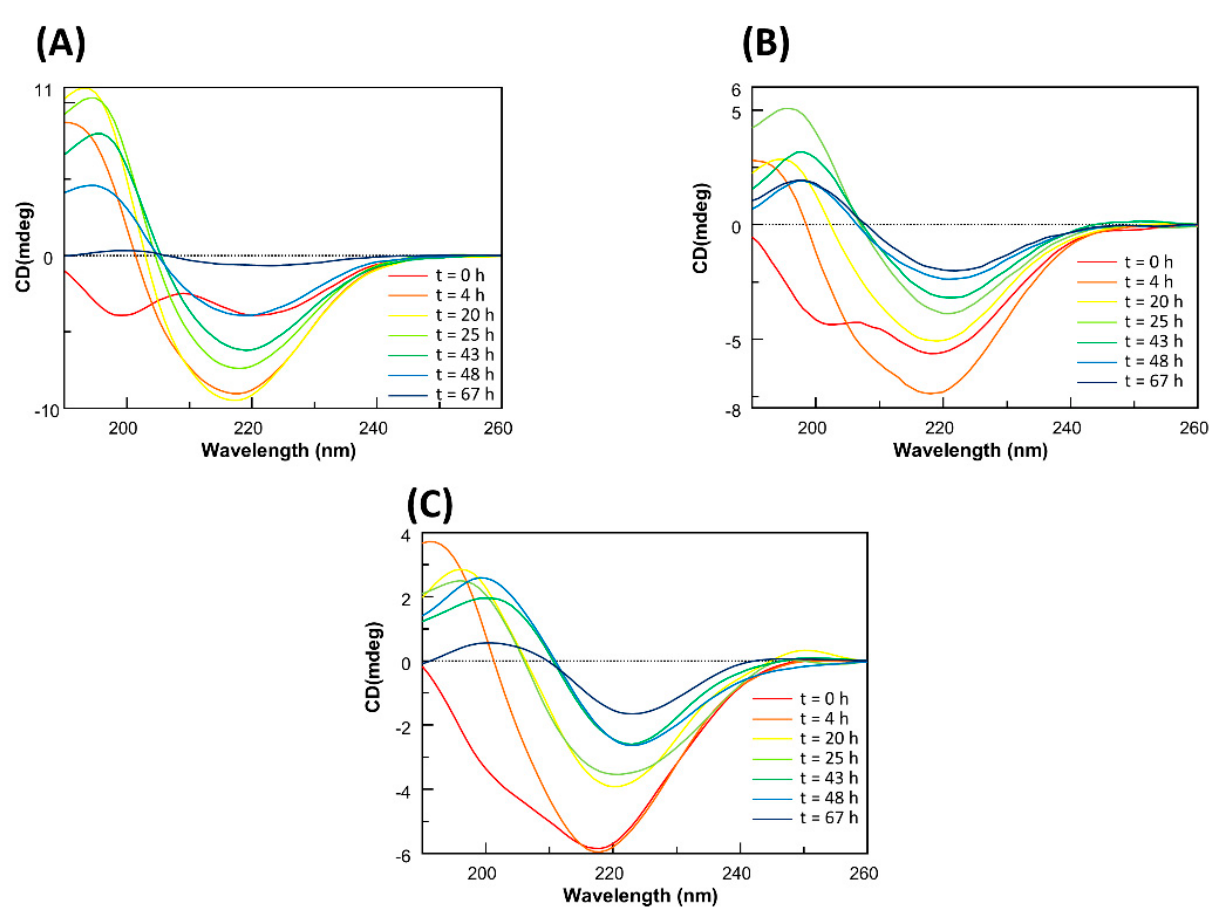
Figure 5. Overlay of CD spectra of A β 21–40 ( A ) alone, incubated with Pt-terpy at ( B ) 1:1 and ( C ) 1:5 peptide: Pt(II) compound molar ratio.